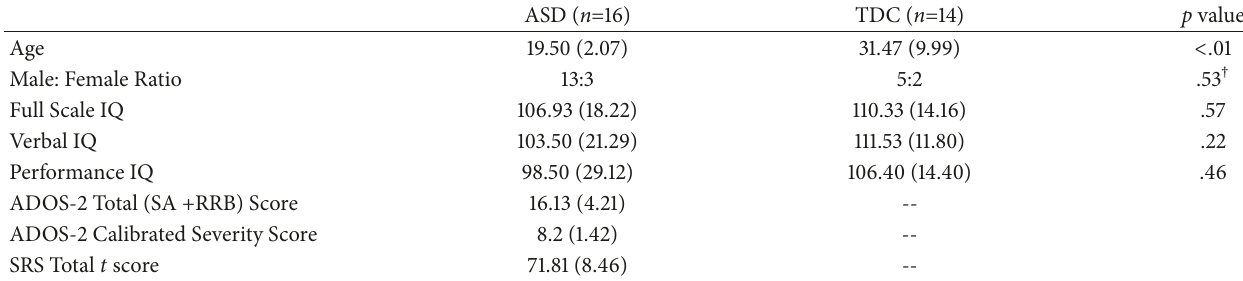
Table 1: Participant characteristics (means and standard